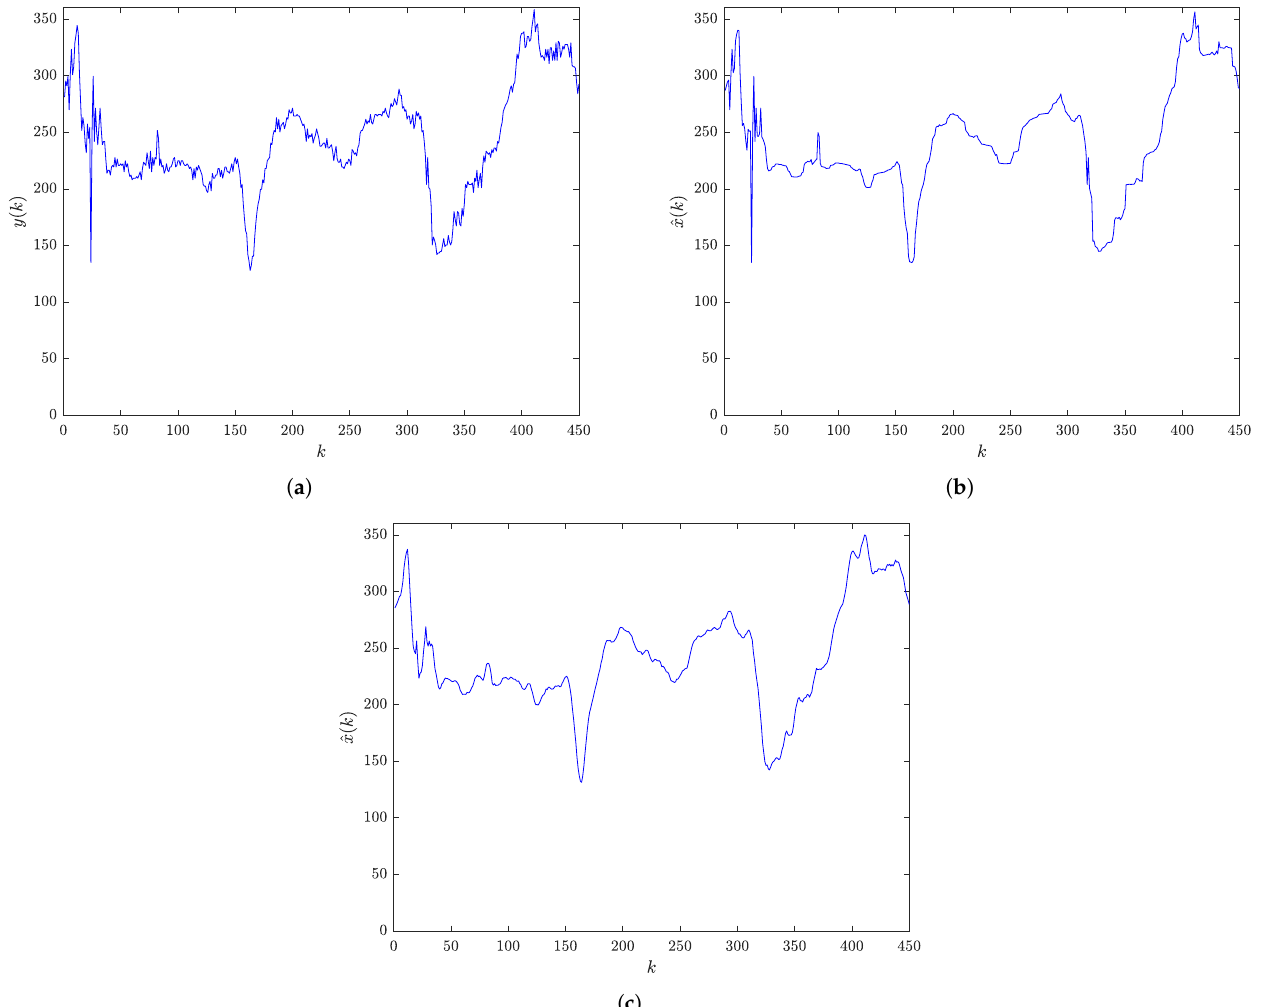
Figure 11. Wave direction: ( a ) Noisy measured signal. ( b ) RBF-RICI filtered signal. ( c ) Savitzky–Golay filtered